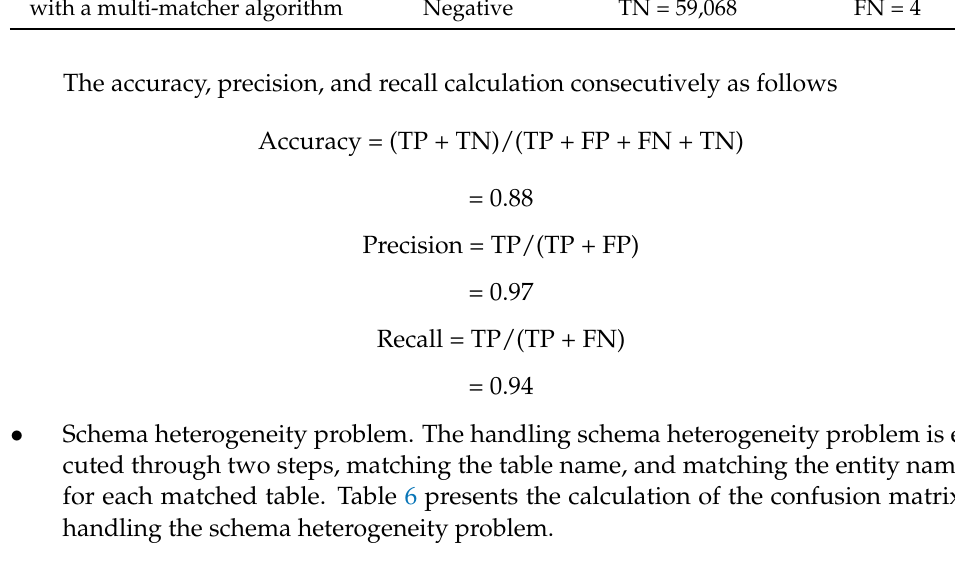
Manual Checking True False Positive TP = 138 FP = 18